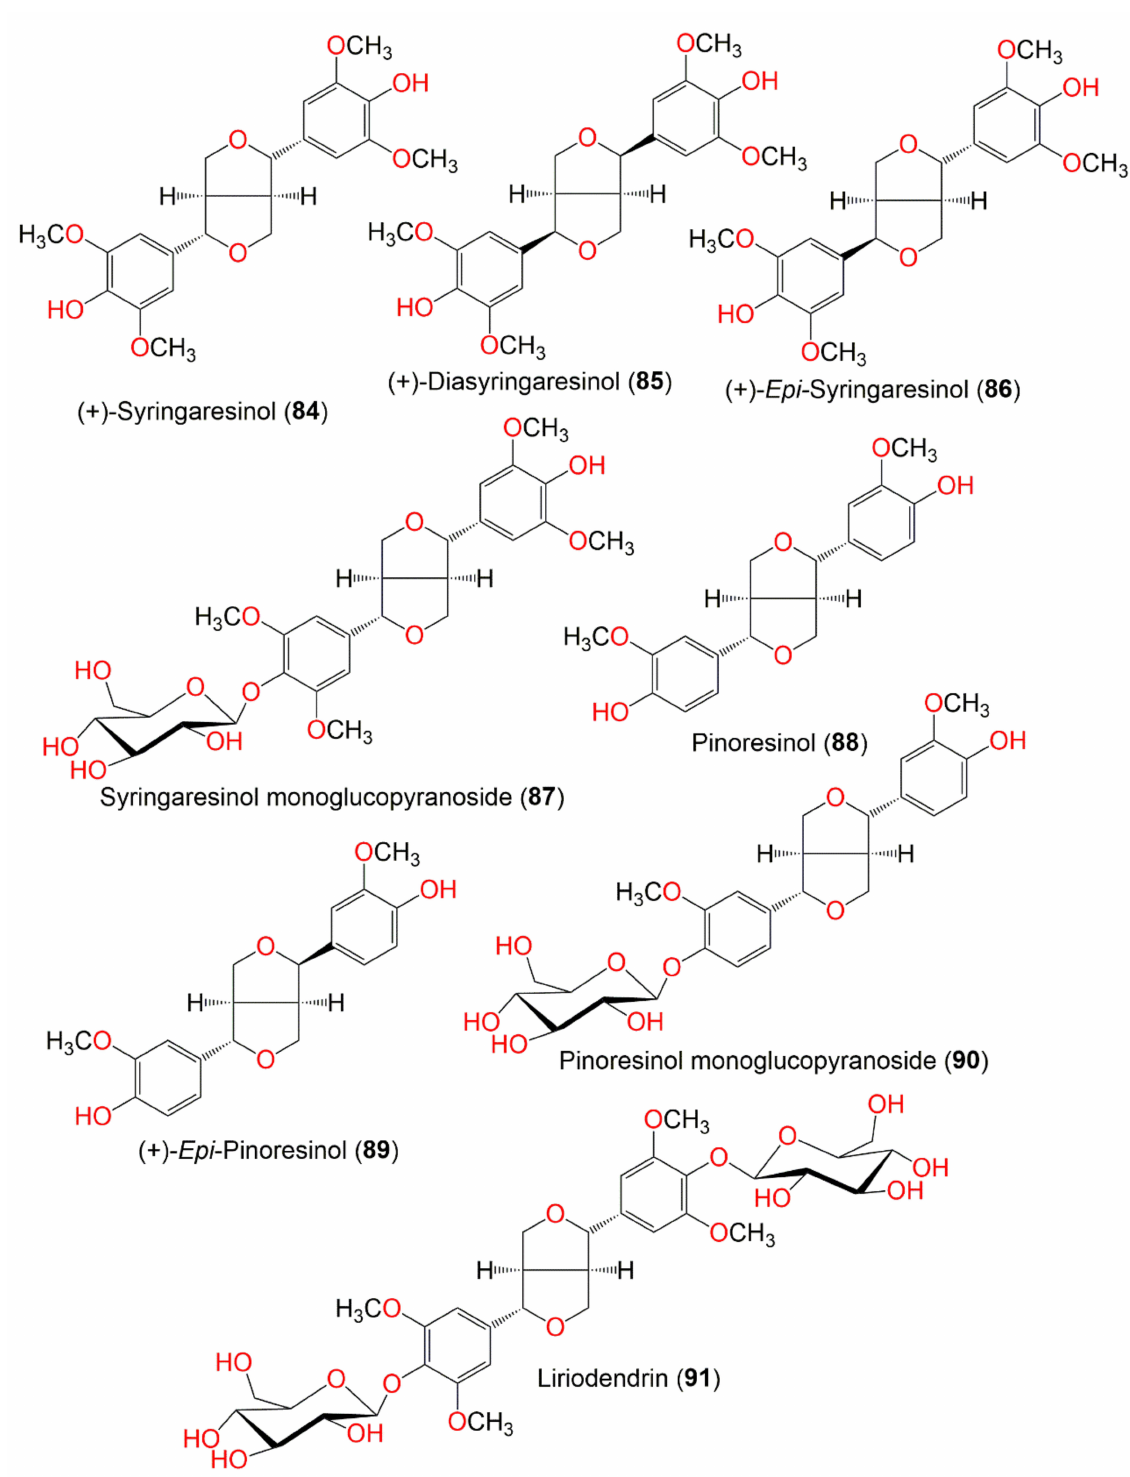
Figure 9. Structures of compounds 84 – 91